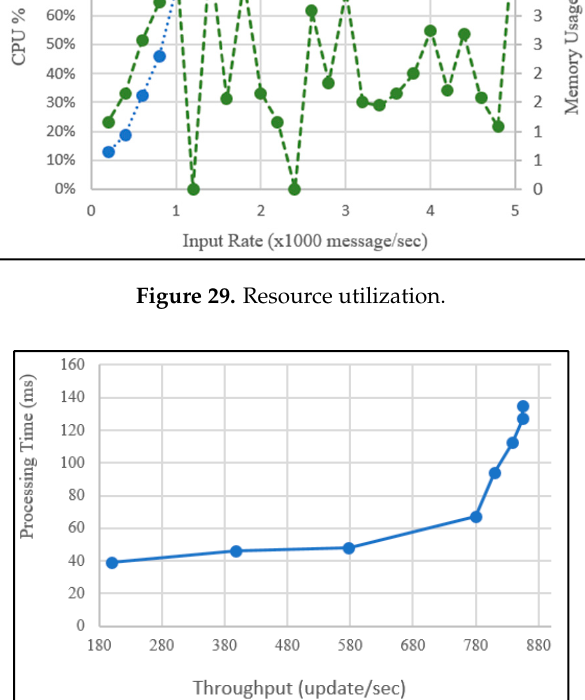
Figure 30. Processing time vs. throughput.